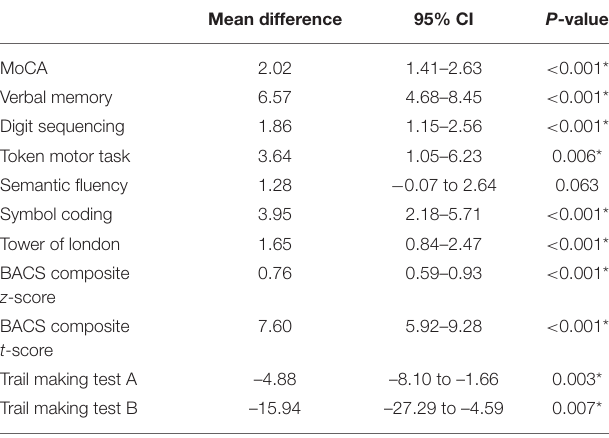
TABLE 2 | Paired t -test results for CRT assessments